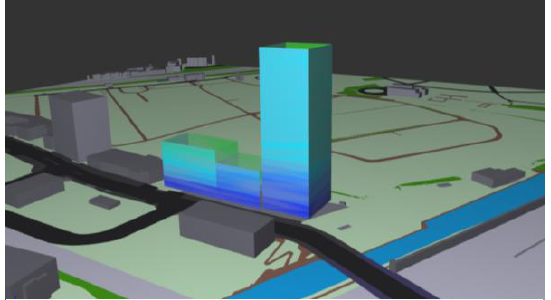
Figure 10 The air quality model with the semi-transparent simplified building model.